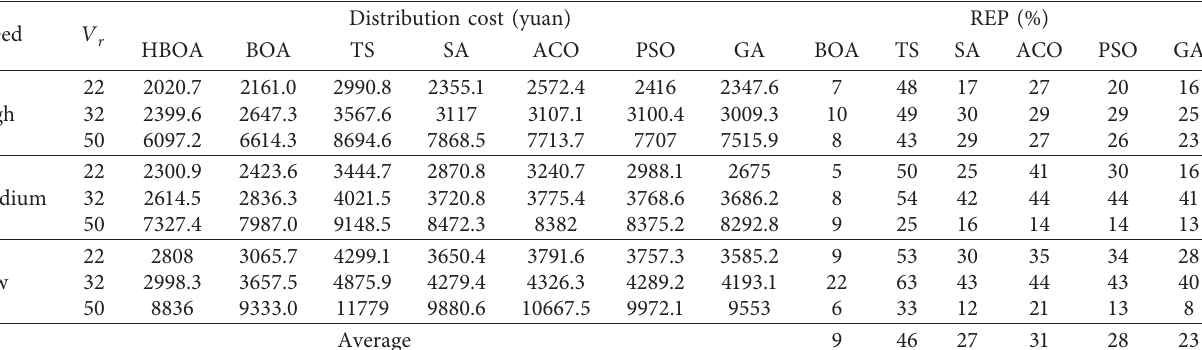
Table 6: Comparison of distribution cost and the relative error percentage (REP) values between the proposed algorithm and other algorithms.